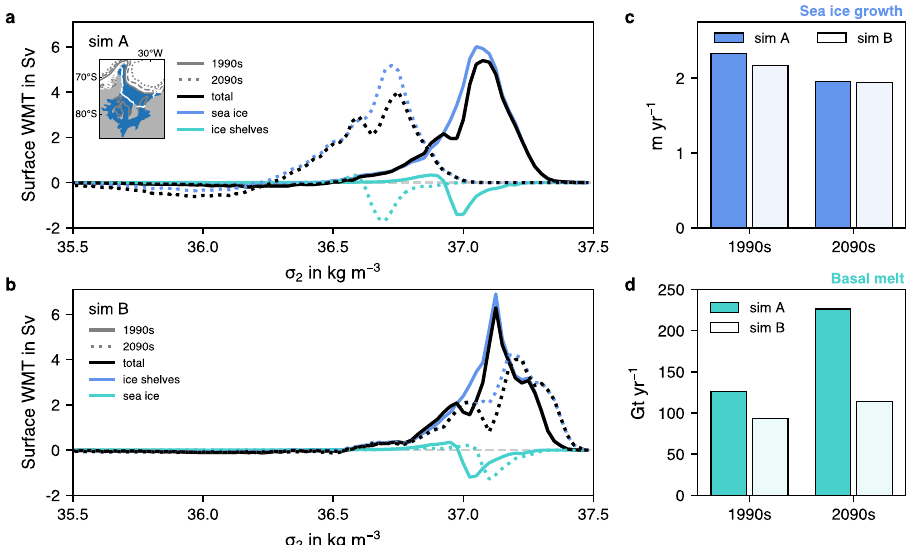
Fig. 7 Water mass transformations due to surface buoyancy fl uxes. a , b Surface water mass transformation rates (WMT) in Sverdrup (Sv; 1 Sv is 1 ⋅ 10 6 m 3 s − 1 ) as a function of the potential density anomaly ( σ 2 in kg m − 3 , i.e., potential density referenced to 2000 dbar minus 1000 kg m − 3 ) due to the total buoyancy fl ux (black) and due to buoyancy fl uxes from sea ice (blue) and ice shelves (mint) on the southern Weddell Sea continental shelf (see blue area in map) in the 1990s (solid) and 2090s (dotted) from a simA (historical + SSP5-8.5 scenario) and b the control simulation simB . Positive transformations denote a densi fi cation of surface waters due to buoyancy fl uxes. Transformations due to heat fl uxes and freshwater fl uxes from evaporation minus precipitation are an order of magnitude smaller than those shown here (see Supplementary Fig. 10). c Sea-ice growth in m yr − 1 and d ice-shelf basal melt rates in Gt yr − 1 in the 1990s and 2090s in simA (darker colors) and simB (lighter